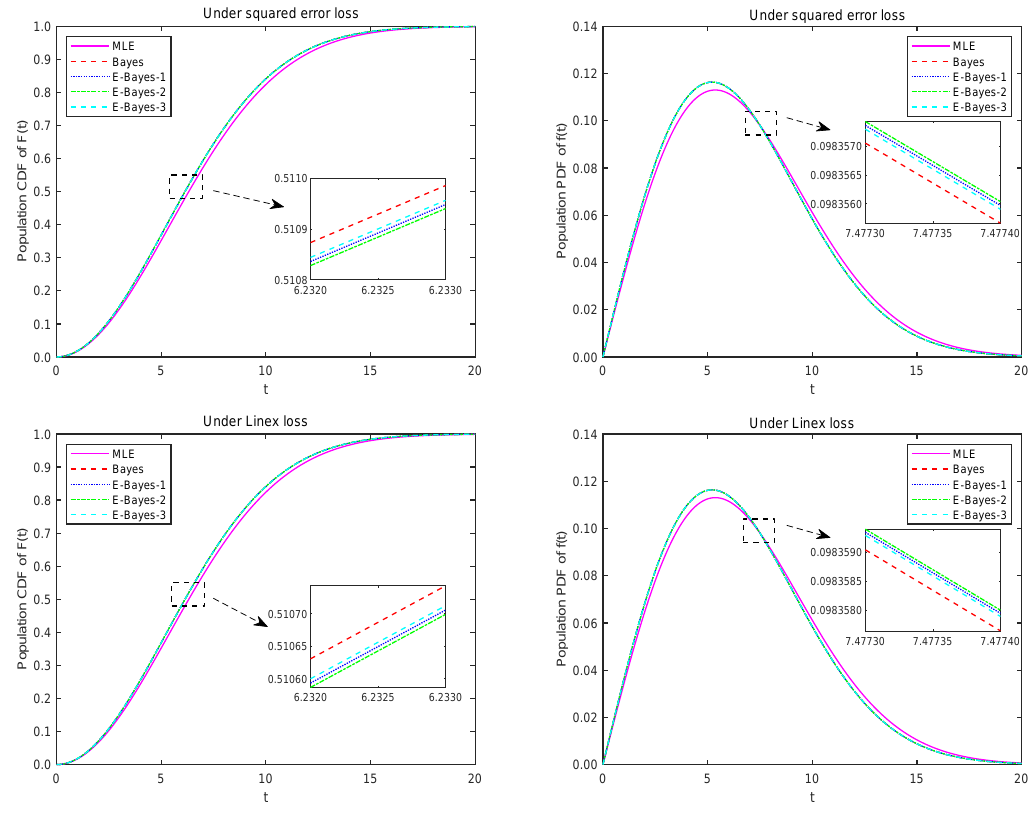
Figure 2. The CDF and PDF plots of Rayleigh distribution for real data.